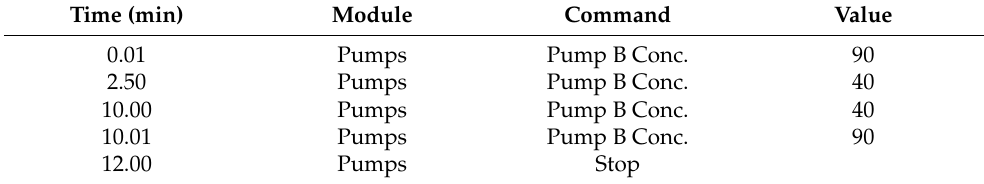
Table 2. Liquid chromatography operating parameters and mobile phase gradient